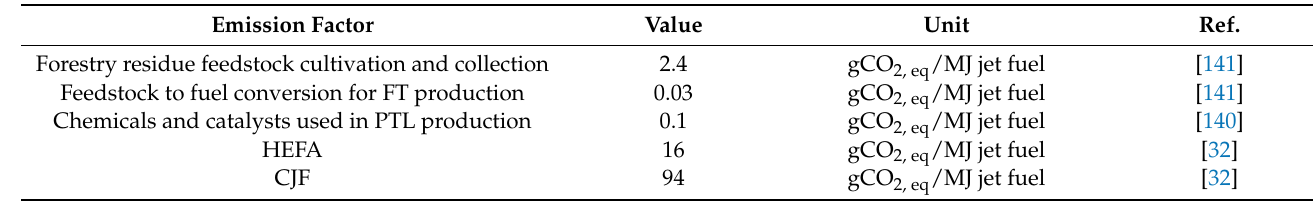
Table 8. Emission factors used in the